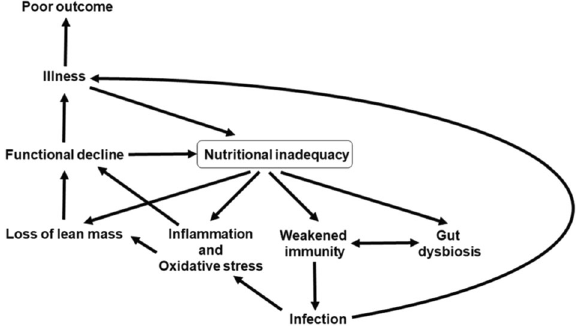
Fig. 5 Factors linking nutritional inadequacy with infection and poor outcome from